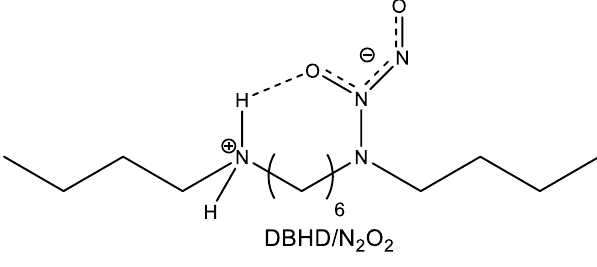
Figure 6. The chemical structure of dibutylhexyldiamine diazeniumdiolate.